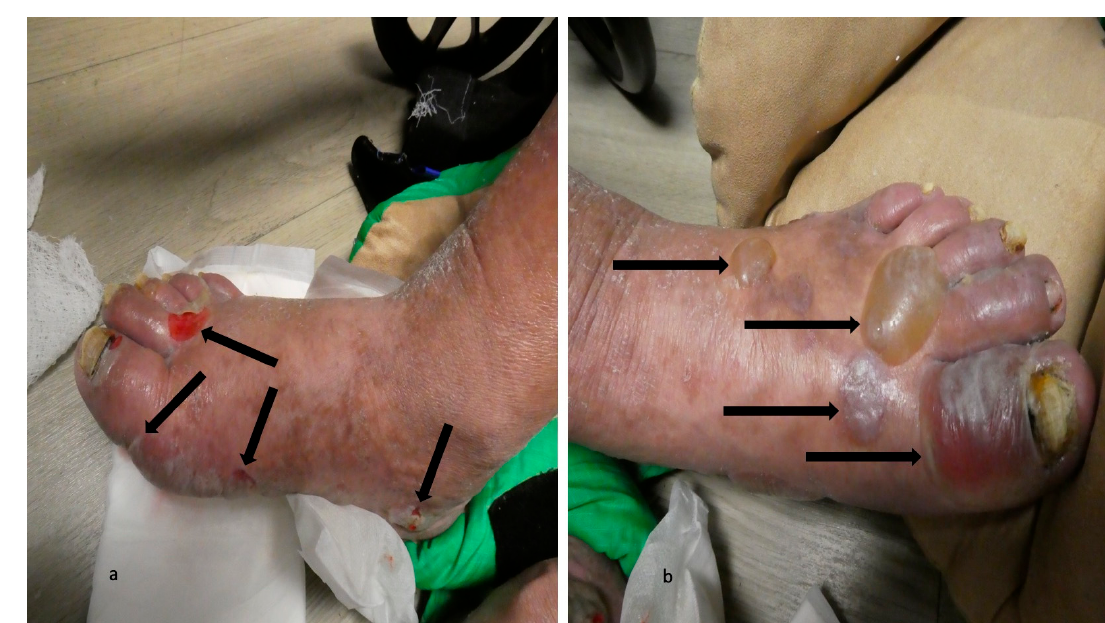
Figure 3. Dyshidrosiform bullous pemphigoid presenting as plantar blisters. Hemorrhagic and deroofed blisters (black arrows) on both the dorsal and lateral surface of the right foot ( a ) and left foot ( b ) of a 65-year-old man; some of the blisters extend to the soles. The figure and legend were originally published in Cureus under the Creative Commons (CC-BY): https://creativecommons.org/licenses/ on 11 January 2020 (Cohen PR: Dyshidrosiform bullous pemphigoid: Case reports and review. Cureus. 2020 Jan 11:12(1):e6630) and are republished with permission.